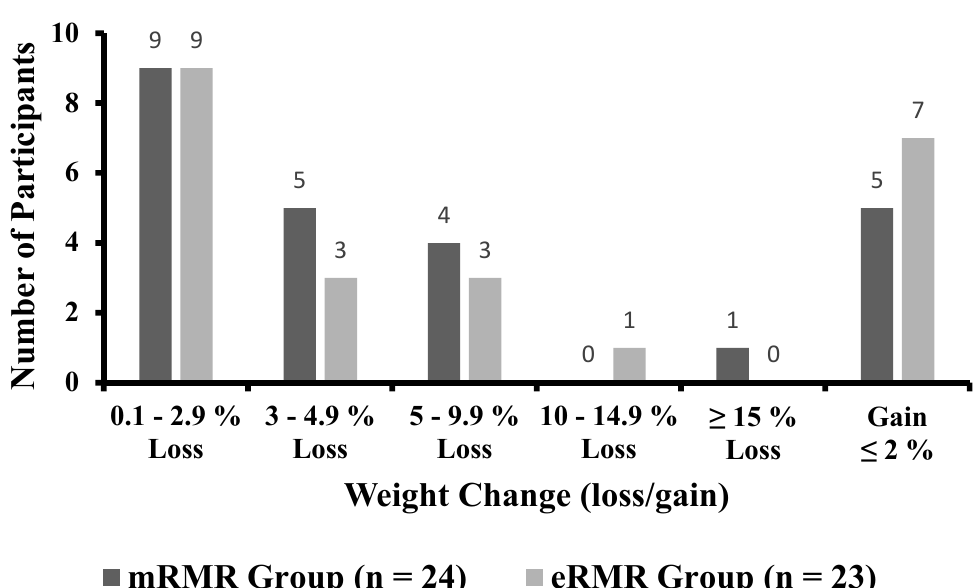
Figure 2. Individual response to weight change for participants completing pre and post measures in the mRMR ( n = 24) and eRMR groups ( n = 23). 3.4. Body Mass Index